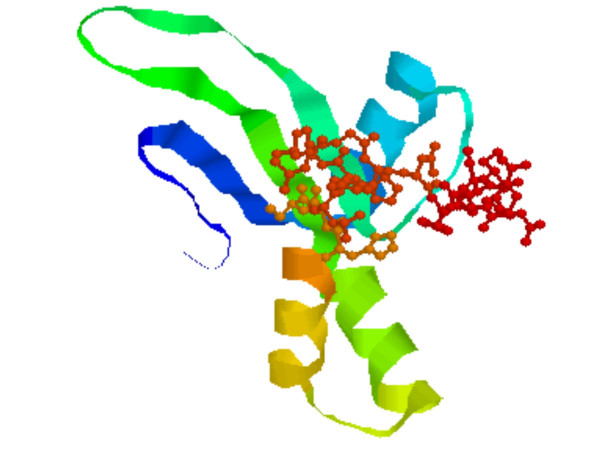
Homology model of the predicted hydrolase Bfl316. (template:1OZ9.pdb; hypothetical protein Aq_1354 of Aquifex aeolicus). The model starts at residue 33, a phenylalanine. The family signature (UPF, residues from 113 to 130 in Bfl316) is indicated in ball-and-stick. Note that in the template 1OZ9 from pdb databank the structure coordinates are exactly known, however the protein function explained in results was not previously apparent.